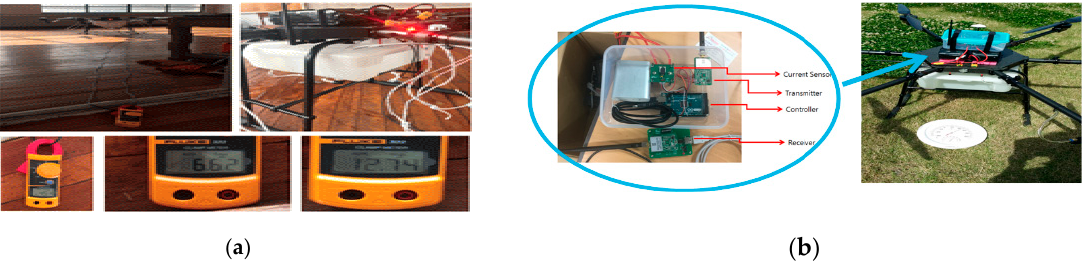
Figure 11. Testing prototype ( a ) and the transmission/reception module when mounted on an agricultural drone ( b ).